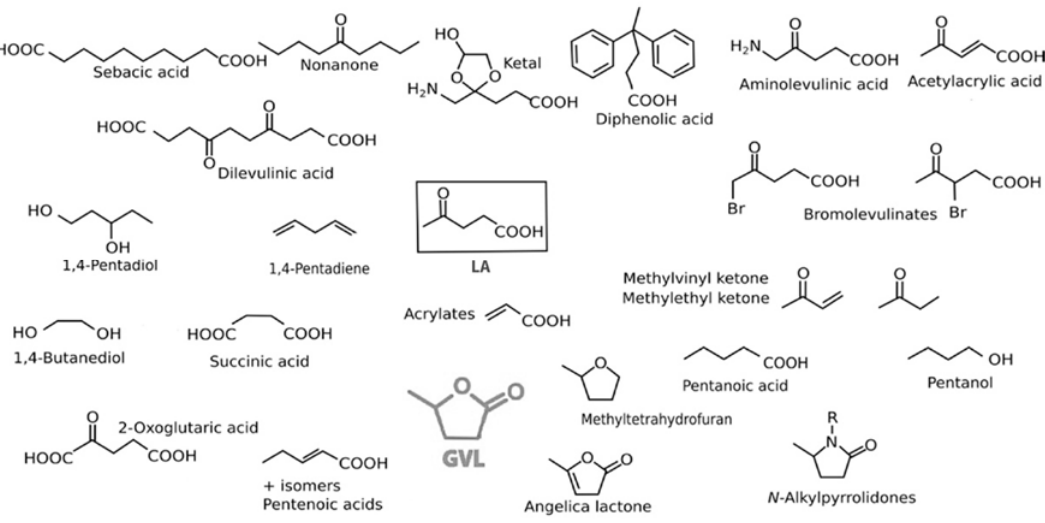
Figure 3. Chemical products derived from LA. Adapted from Ref. [98].